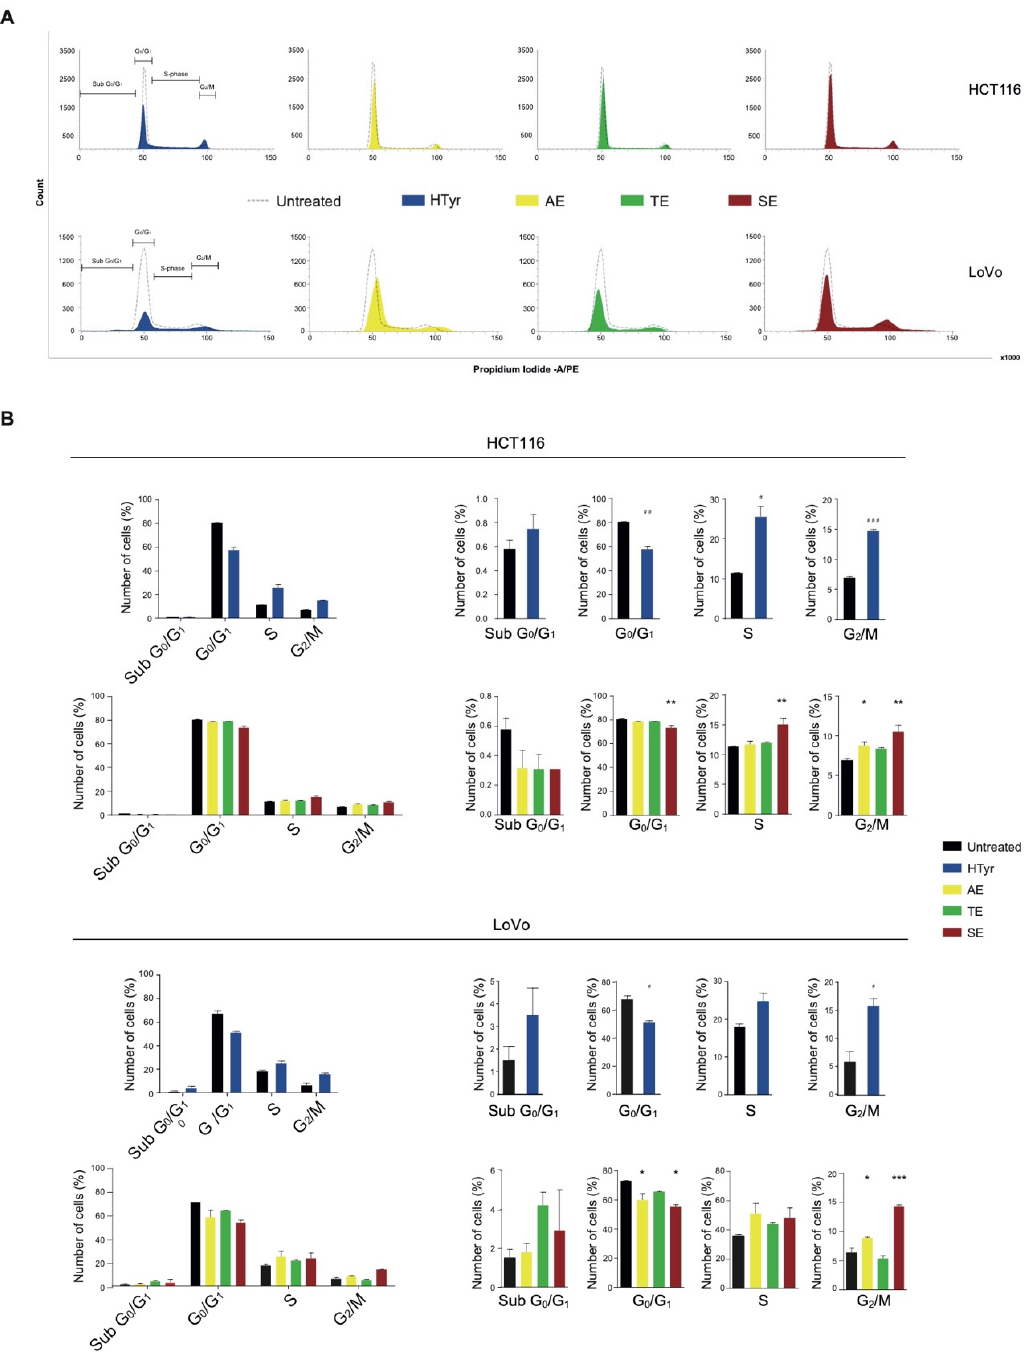
Figure 5. Hydroxytyrosol and OPWPs extracts induce a cell cycle arrest in colorectal cancer cells: ( A ) Cell cycle flow cytometry analysis of HCT116 cells treated with 0.0154 mg mL − 1 of either HTyr or OPWPs extracts (upper panel) and LoVo cells treated with 0.0231 mg mL − 1 of either HTyr or OPWPs extracts (lower panel) for 72 h. The horizontal bars indicate the various cell cycle phases in both cell lines. ( B ) The percentages of cells in each cell cycle phase for both cell lines were quantitated and reported as histograms considering all phases together (left) or showing details of each distinct phase (right). Statistical significance is considered when # p ≤ 0.05, ## p ≤ 0.01, ### p ≤ 0.001 ( t -test) or * p ≤ 0.05, ** p ≤ 0.01, *** p ≤ 0.001 (ANOVA with Dunnett’s